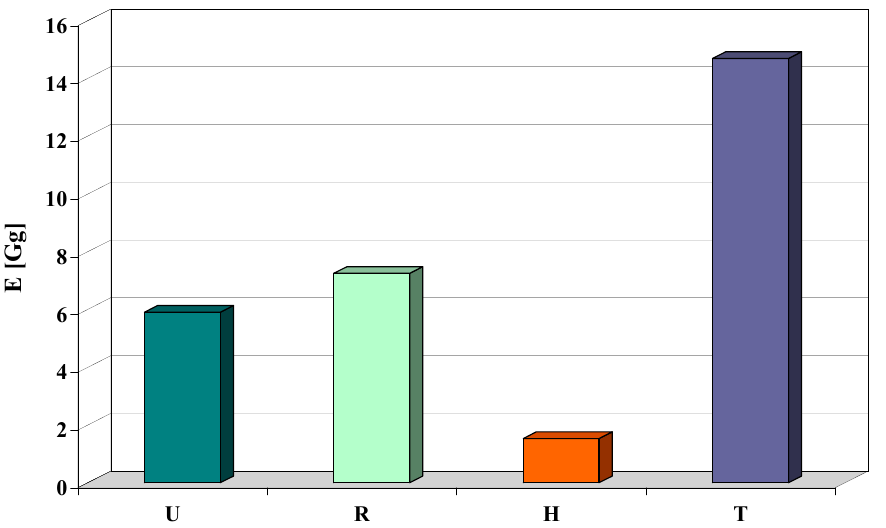
Figure 8. National annual emissions (E) of non-exhaust total suspended particles (PM-TSP-N-Exh) under different traffic conditions: urban (U), rural (R), highway (H) and total (T).